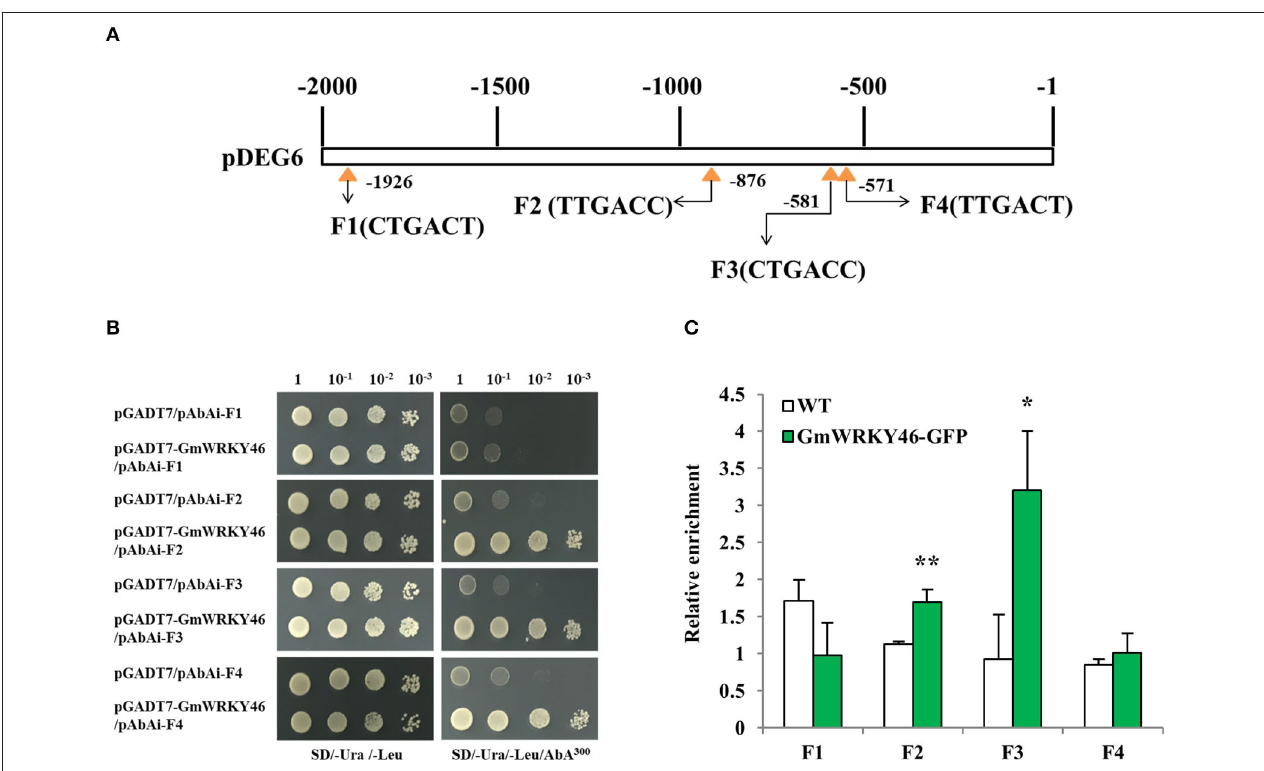
FIGURE 7 | GmWRKY46 binds to DEG6 promoter region in vivo and in vitro . (A) Diagram of the 2000-bp promoter region of DEG6 showing the relative positions of the W-boxes. Four W-boxes F1, F2, F3, and F4 were marked by yellow triangle. Numbers indicated the position of starting nucleotide of each W-box relative to translation start. (B) GmWRKY46 binds to the DEG6 promoter region in the Y1H assay. Yeast cells were transformed with a bait vector containing a promoter fragment F1, F2, F3, or F4 fused to pAbAi vector, and a prey vector containing GmWRKY46 fused to pGADT7 vector. Yeast cells were grown in liquid medium to an OD600 of 1.0 and diluted in a 10 × dilution series (10 − 1 -10 − 3 ). From each dilution, 5 µ l was spotted onto SD/-Ura/-Leu medium to select for plasmids, and SD/-Ura/-Leu supplemented with 300ng/ml Aureobasidin A (AbA) to select for interaction. Empty pGADT7 was used as control. (C) ChIP-qPCR analysis of GmWRKY46 binding to the DEG6 promoter region. Arabidopsis seeds of WT and Pro35S:GmWRKY46-GFP transgenic plants were germinated in medium and supplied with sufficient Pi. The whole plants were harvested for ChIP analysis. Enriched DNA fragments (F1 to F4) in the DEG6 promoter were quantified using RT-qPCR. Enrichment was calculated as the ratio of immunoprecipitation to input. Values represent means ± SD ( n = 3). Data significantly different from the control are indicated (Student’s t -test, * P < 0.05; ** P <